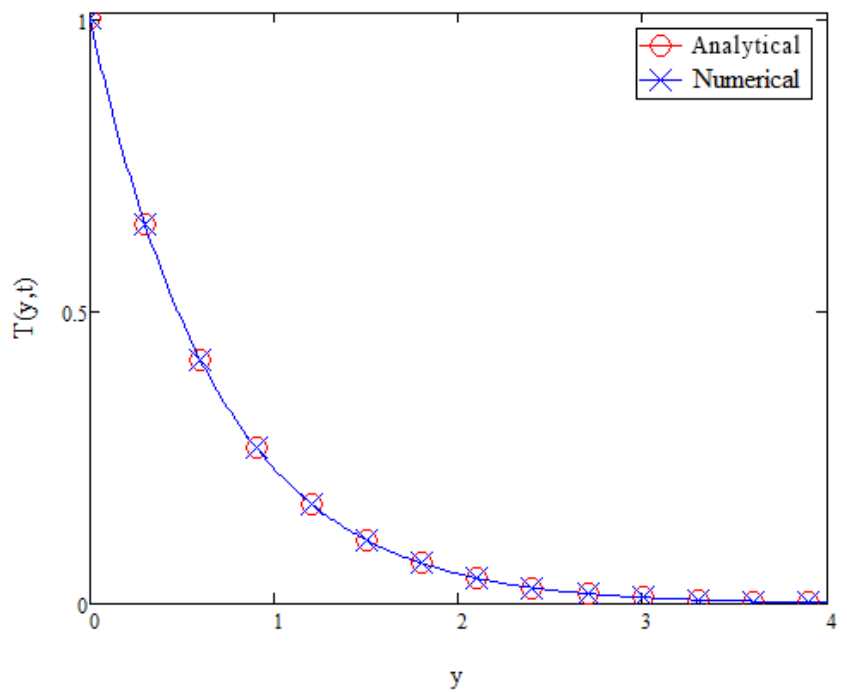
Figure 3. Temperature profile for analytical solution presented in Equation (21) validated with numerical solution using Zakian’s